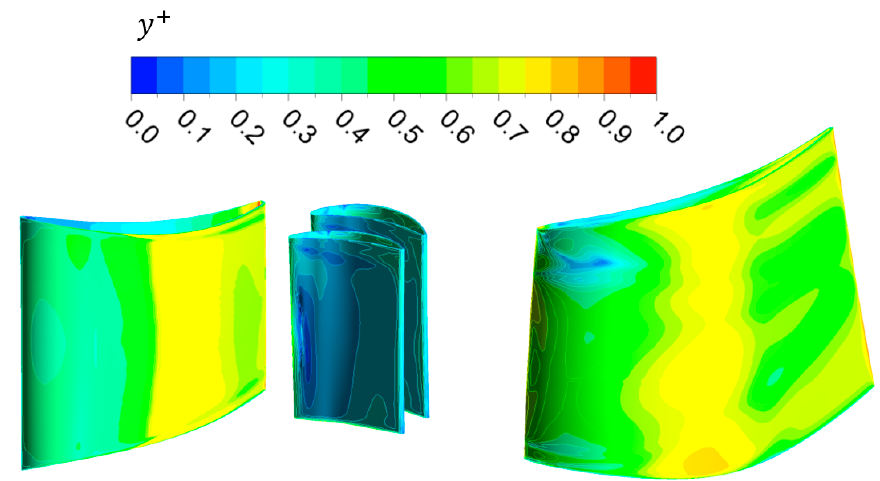
Figure 2. Contour of y + on blades and vanes surface.